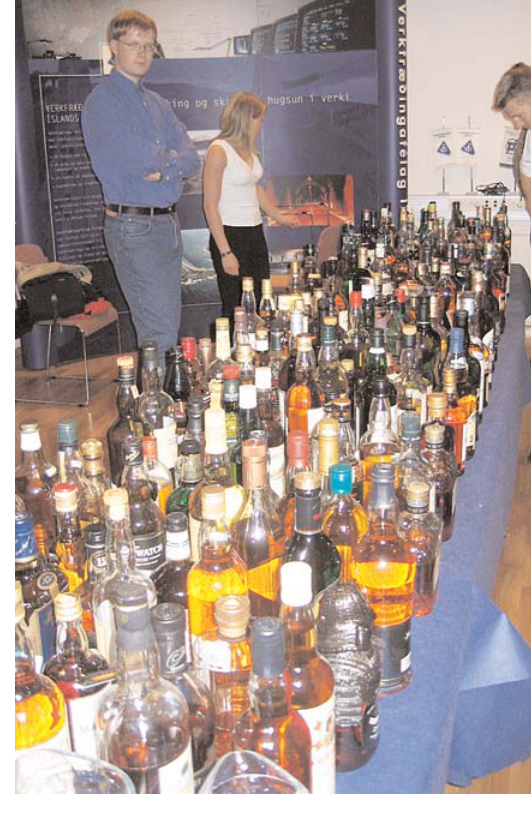
Figure 3: And for something to drink … Yes, it’s all